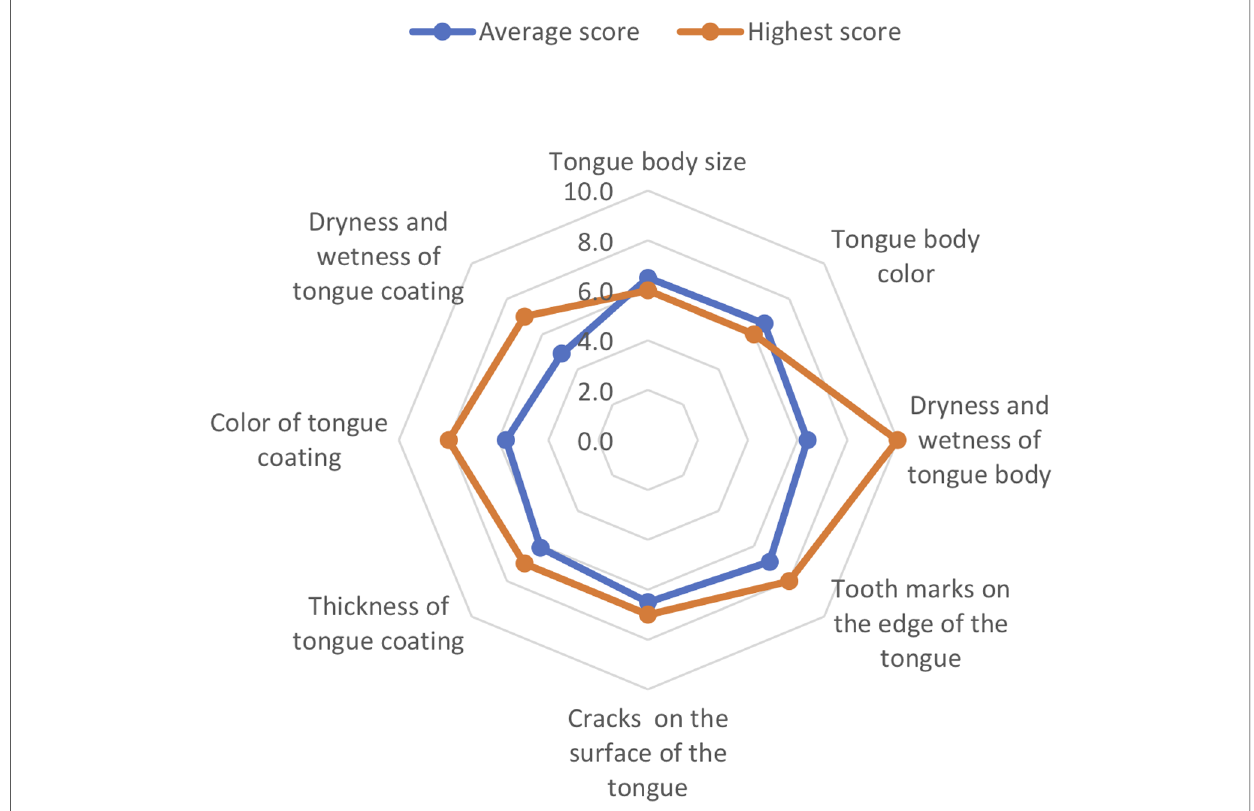
FIGURE 5 Results of the tongue diagnosis test (Study 1): the correct answer rate of 8 aspects Rader chart shows the correct answer rate of 8 aspects. The average number of the correct answer of 10 questions of 15 KSs for each aspect are as follows: 6.5 for tongue size, 6.6 for tongue color, 6.4 for dryness and wetness of the tongue coating, 6.9 for tooth marks, 6.5 for cracks, 6.1 for tongue coating thickness, and 4.9 for dryness and wetness of the tongue body. The data of the highest scorer (KS-E) is also shown. After the test is completed, the test taker's own grades and the average value of all test takers Evaluation of tongue diagnosis ability are displayed on the same chart. Therefore, the test taker can grasp his/her level compared to remaining participants in the